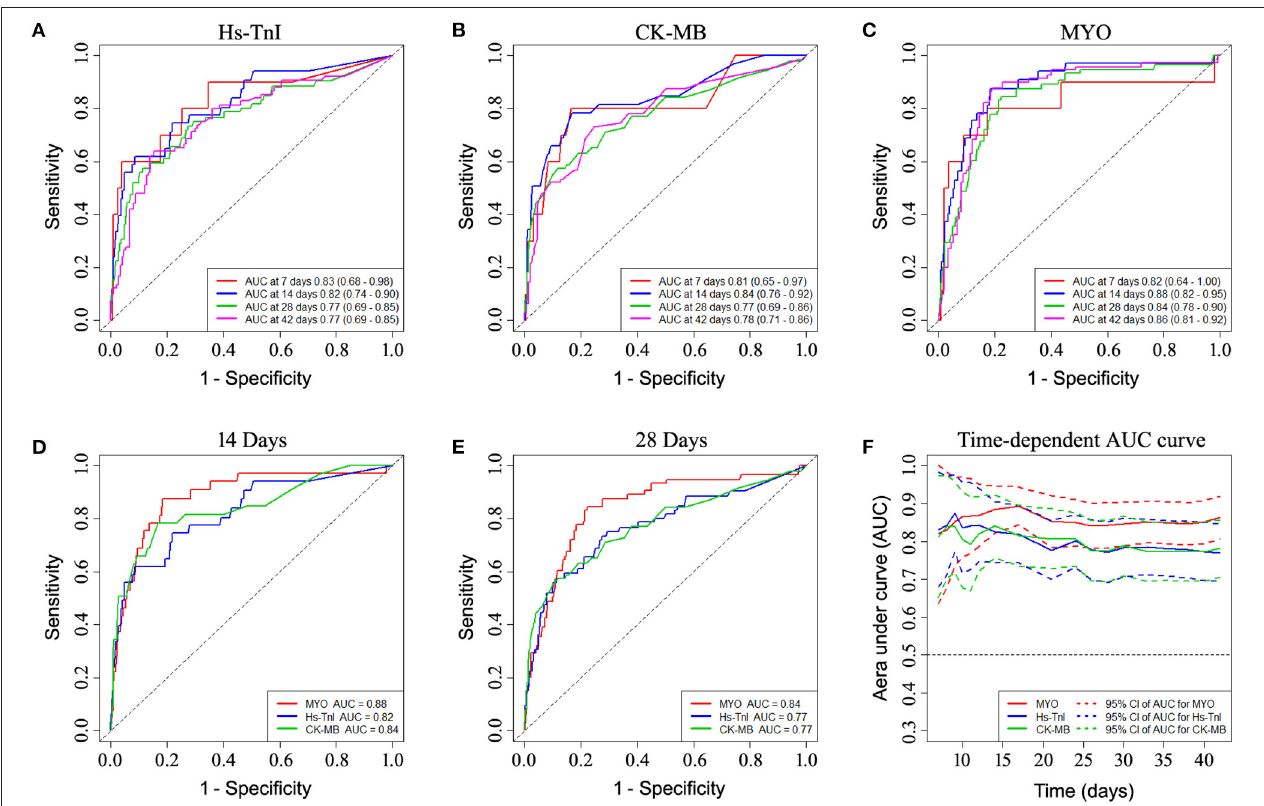
FIGURE 2 | Time-dependent ROC curve analysis based on the early-stage levels of myocardial biomarkers showing the prognostic performance of myocardial biomarkers. (A–C) ROC performance of myocardial biomarkers at different times during follow-up. (D,E) Comparison of the prognostic performance of each biomarker in predicting 14-day and 28-day mortality. (F) Time-dependent AUC curves of myocardial markers showed superior AUC values for myoglobin over hs-TnI and CK-MB throughout the follow-up period. ROC, receiver operating characteristic curve; AUC, area under